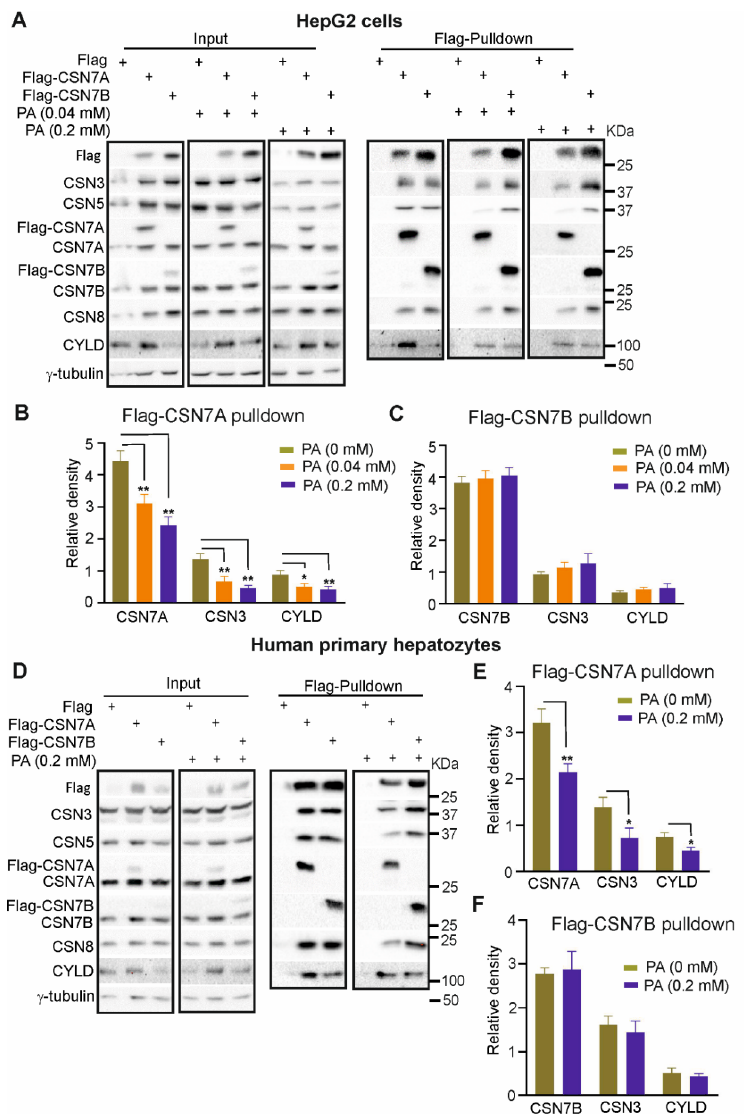
Figure 5. Overexpression of CSN7A, but not of CSN7B, stabilizes CYLD. ( A ) Western blots of 1.2 × 10 7 HepG2 cells transiently transfected with 60 µ g Flag-vector (control), Flag-CSN7A or Flag-CSN7B. 24 h after transfection, cells were treated with 0, 0.04 or 0.2 mM PA for another 24 h. Cells were harvested for Western blots (left three panels) or Flag pulldowns (right three panels). Antibodies were used as indicated. ( B , C ) Blots of Flag-pulldowns as shown in ( A ) (right three panels) were quantified by densitometry to measure the abundance of CSN7A, CSN3, and CYLD in Flag-CSN7A pulldowns ( B ) or of CSN7B, CSN3 and CYLD in Flag-CSN7B pulldowns ( C ) after treatment with 0, 0.04 and 0.2 mM PA. Data are expressed as means of relative density plus/minus standard deviations (SD, n = 3). Unpaired Student’s t -test was used for statistical analysis. * p < 0.05, ** p < 0.01. ( D ) Western blots of human primary hepatocytes transiently transfected with Flag-vector (control), Flag-CSN7A or Flag-CSN7B as in ( A ). Immediately after transfection, cells were treated with 0 or 0.2 mM PA for 24 h. Cells were harvested for Western blots (left two panels) or Flag pulldowns (right two panels). Antibodies were used as in ( A ). ( E , F ) Blots of Flag-pulldowns as shown in ( D ) (right two panels) were quantified by densitometry to measure the abundance of CSN7A, CSN3 and CYLD in Flag-CSN7A pulldowns ( E ) or CSN7B, CSN3 and CYLD in Flag-CSN7B pulldowns ( F ) after treatment with 0 and 0.2 mM PA. Data are expressed as means of relative density plus/minus standard deviations (SD, n = 3). Unpaired Student’s t -test was used for statistical analysis. * p < 0.05, ** p < 0.01. 2.5. Downregulation of CSN7B Induces CYLD and Hinders Steatosis in HepG2 Cells Mild steatosis in HepG2 cells can be induced by endogenous lipids after five to eight days. Steatosis in HepG2 cells was monitored for two and eight days by ORO